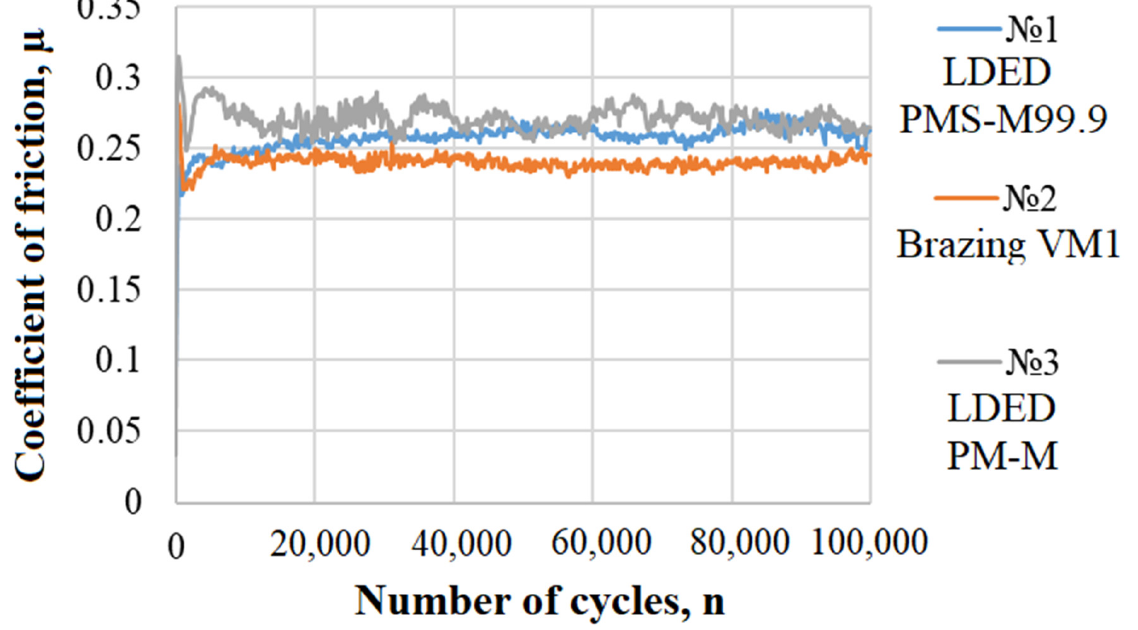
Figure 13. Dependence of friction coefficients on the number of cycles.